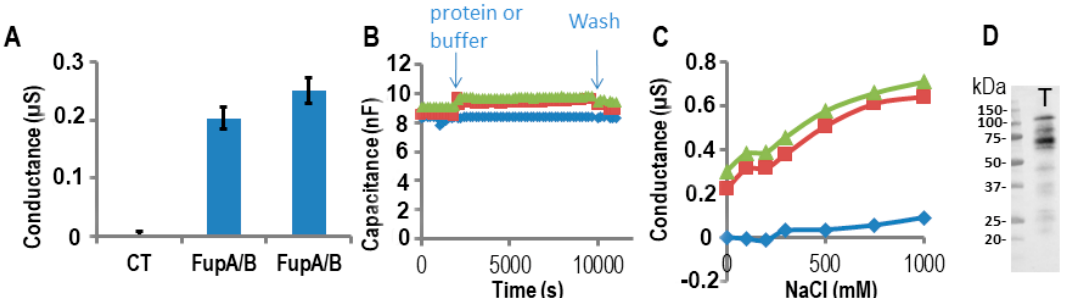
Figure 3. Measurements of FupA/B porin activity using impedance spectrometry on a TethaPod chip. FupA/B was digested by the TEV enzyme in the well. ( A ) The conductance of the t-LBM after the insertion of FupA/B (2 independent wells) and no protein (CT) in 50 mM Tris pH 7.5, 200 mM KCl. The conductances are the mean (± SD) of the conductances measured over 10 min. ( B ) The capacitance of the t-LBM before and after incorporation of FupA/B (2 independent wells: red squares and green triangles) or buffer (blue diamonds). The times of protein addition and washes are indicated. Fifteen data points were used for each measurement. ( C ) The conductance after NaCl addition in the upper compartment of the t-LBM after incorporation of FupA/B (2 independent wells: red squares and green triangles) or buffer (blue diamonds). The conductances are the mean of the conductances measured during NaCl incubation (10 min for each NaCl concentration). ( D ) Immunoblot analysis using the anti-FupA antibody of FupA/B solubilized in the t-LBM well by SDS (lane T). Marker molecular weights are indicated (kDa).